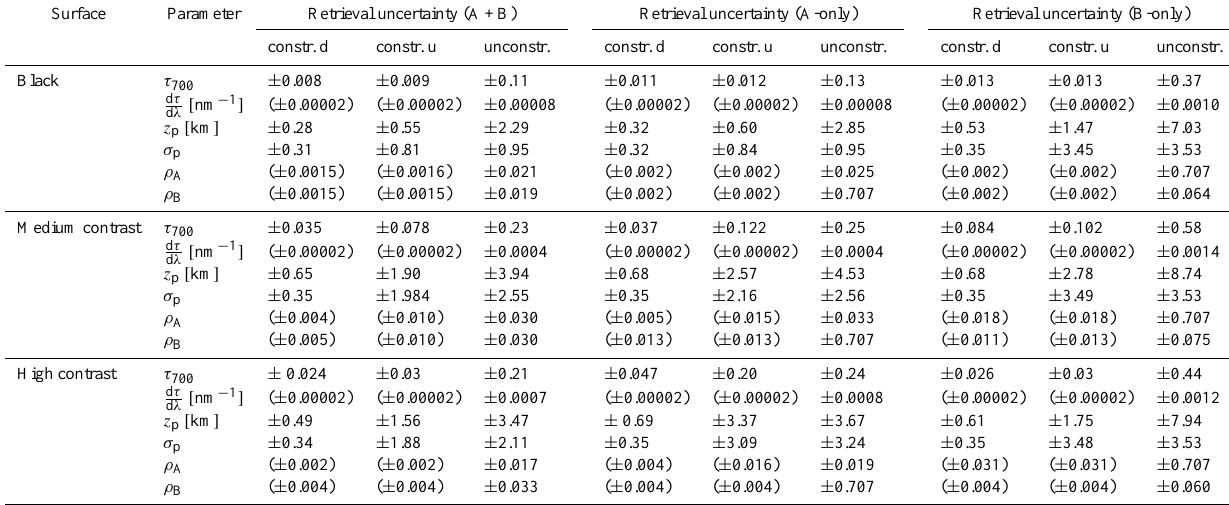
Table 3. Accuracy of retrieval for each retrieved parameter for different retrieval set-ups (obtained from a posteriori variances). Surface Parameter Retrieval uncertainty (A+B) Retrieval uncertainty (A-only) Retrieval uncertainty (B-only) constr. d constr. u unconstr.